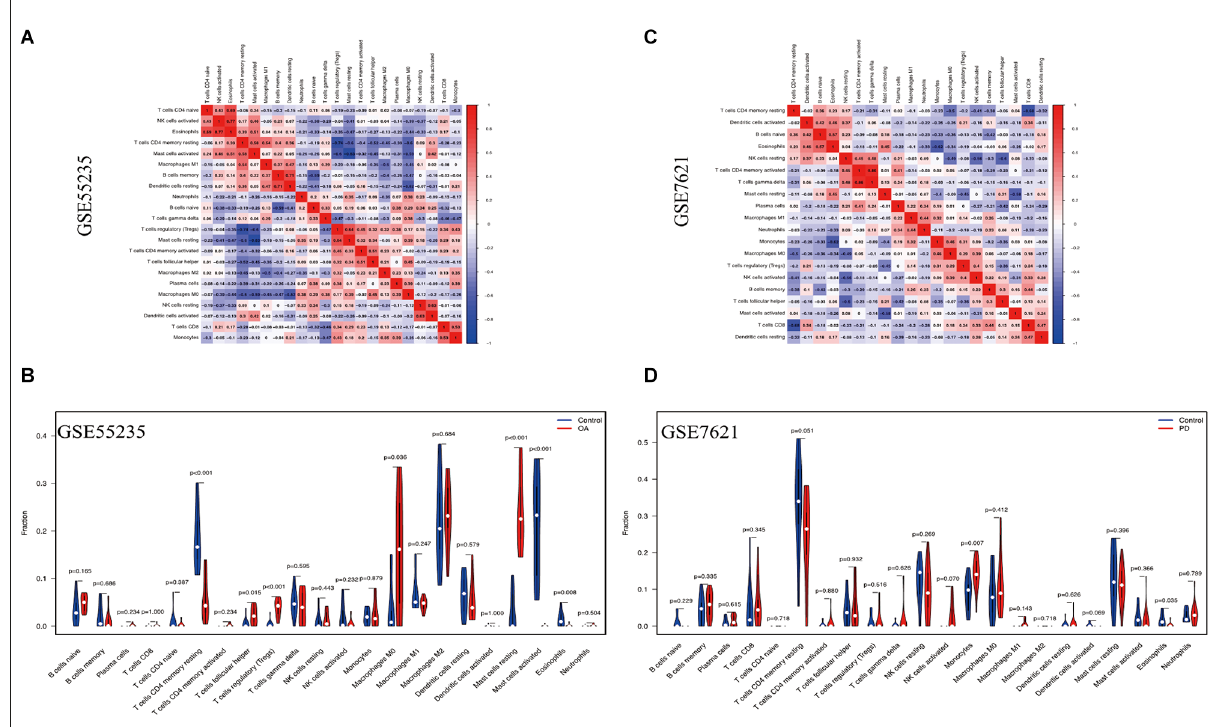
FIGURE9 Immune cell infiltration analysis. (A,B) The correlation heat map depicted the link between 22 invading immune cells. Red squares indicate positive correlations, while blue squares indicated negative correlations. The size of the squares indicated the strength of the association. (C,D) The violin plot showed the distinction of 22 infiltrating immune cells among the OA and PD samples.